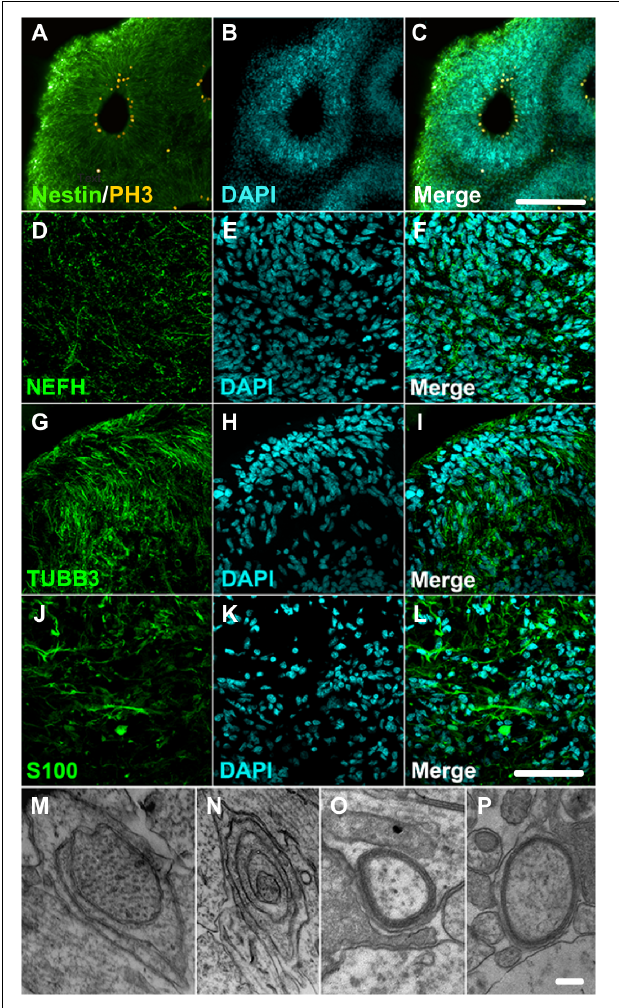
FIGURE 3 | Cerebral organoids expressing neuronal and glial proteins. (A–C) Immunostaining of 30-day cerebral organoids with nestin (green) and showing proliferative areas with PH3 (yellow). Immunostaining of 45-day cerebral organoids with neuronal markers (D–F) neurofilament 200 (NEFH), and (G–I) tubulin β III (TUBB3), or glial marker (J–L) S100 protein in cryosections. Nuclear staining with DAPI. (M–P) Transmission electron microscopy images showing myelin sheath formation around some cells of cerebral organoids. Scale bars shown correspond to (A–C) 200 µ m, (D–L) 50 µ m, and (M–P) 1 µ m.